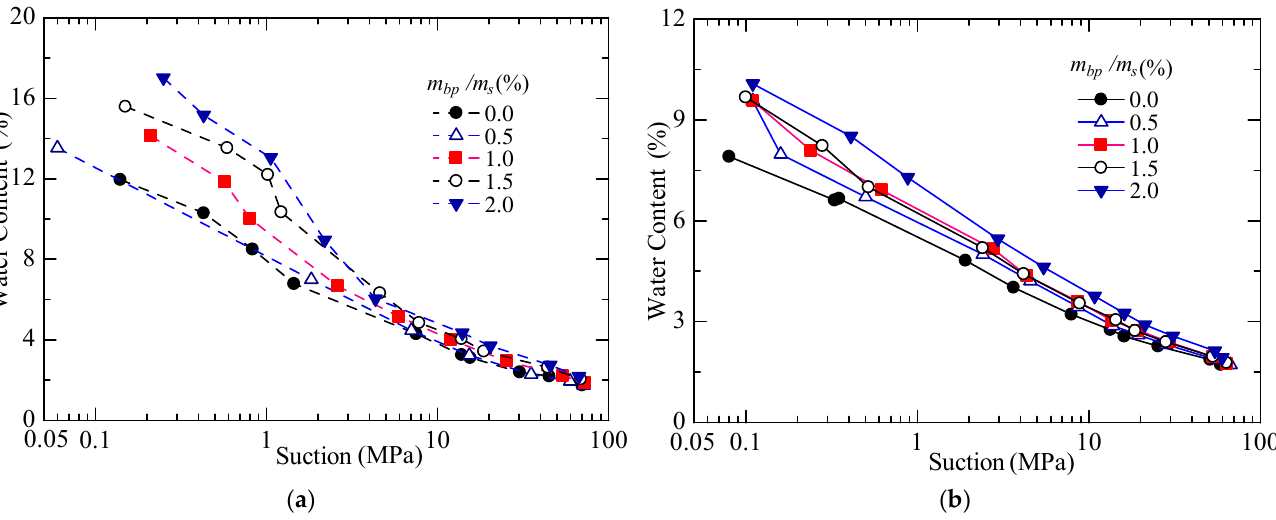
Figure 13. Water retention curves of silt with different XG contents: ( a ) drying process; ( b ) wetting process.